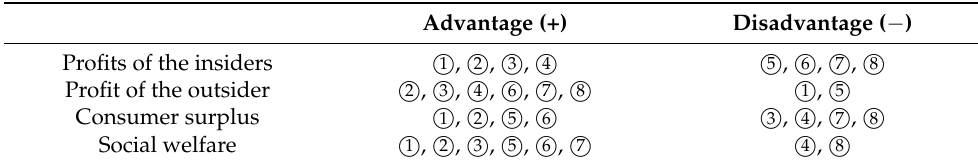
Figure 2. Effects of merger with responsive expectation. Table 1. Effects of merger with responsive